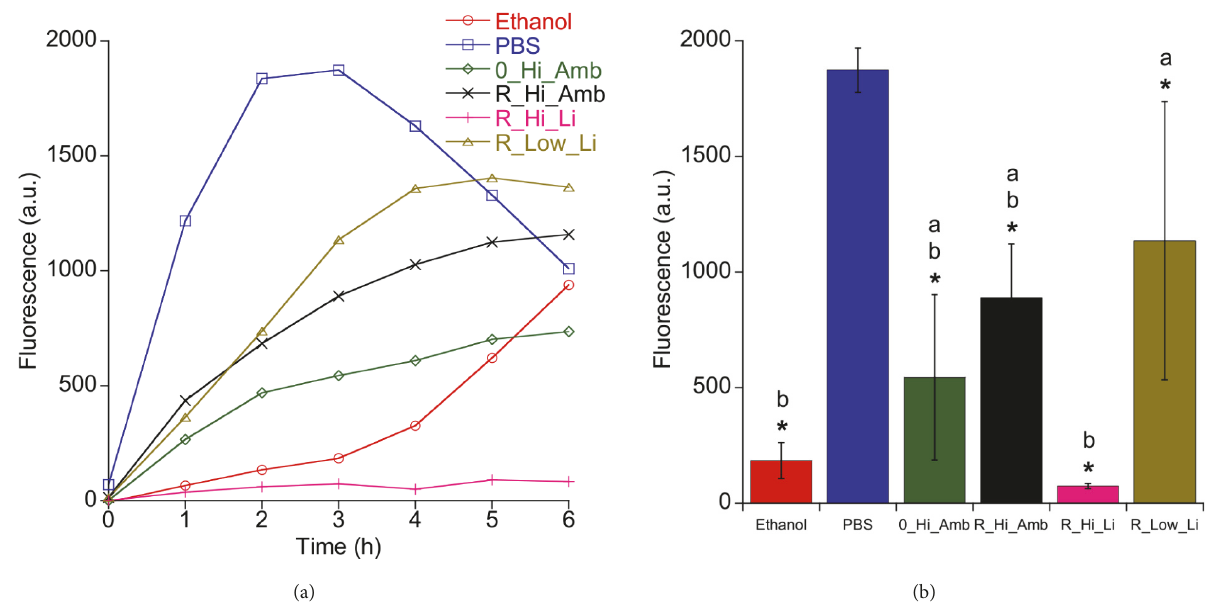
Figure 1: Regrowth of S . epidermidis after different debridement treatments. Background fluorescence from TSB was subtracted from all test groups. (a) Average fluorescence intensity measured during reincubation after debridement with different treatments (n=8). (b) Average fluorescence intensity after 3 h regrowth. Groups with an asterisk indicate statistically significant difference compared to the control PBS (Dunnett post hoc test, p ≤ 0.05). Groups with different letters are significantly different (five test groups compared, Tukey post hoc test, p ≤ 0.05).